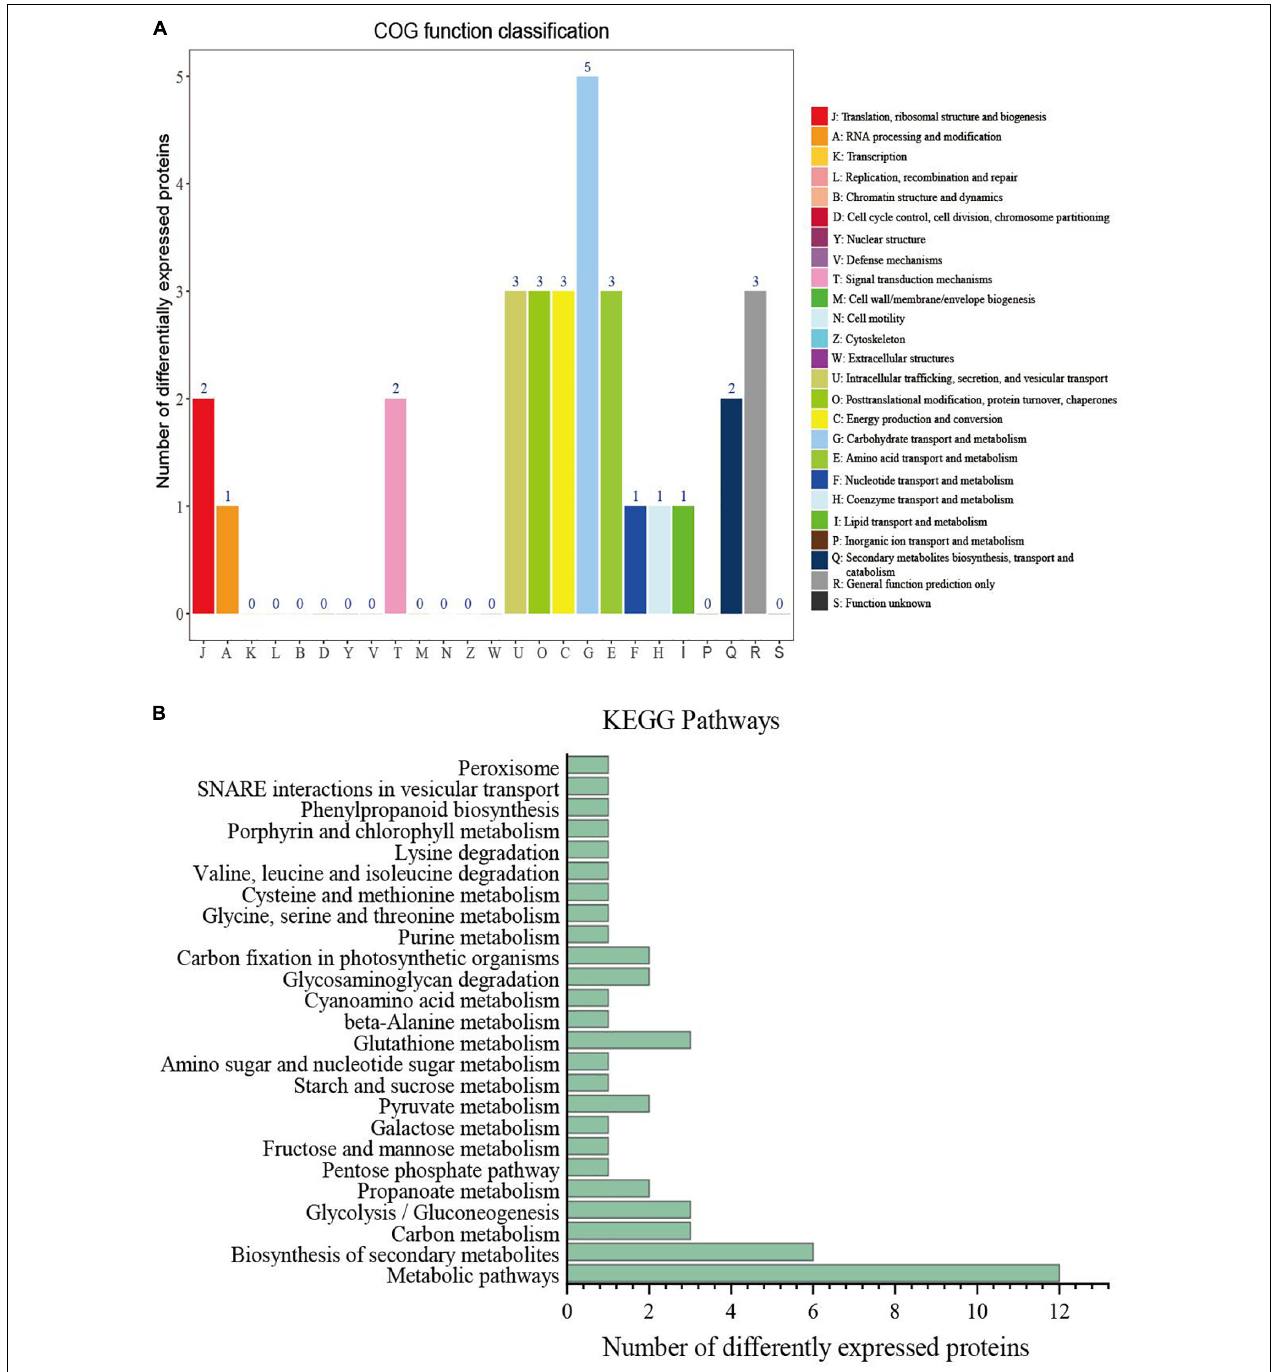
FIGURE 4 | Clusters of orthologous groups (COG) functional annotation and Kyoto Encyclopedia of Genes and Genomes (KEGG) enrichment analysis of differentially expressed protein (DEPs). (A) COG function classification of 45 co-expressed DEPs. (B) KEGG function classification of 45 co-expressed